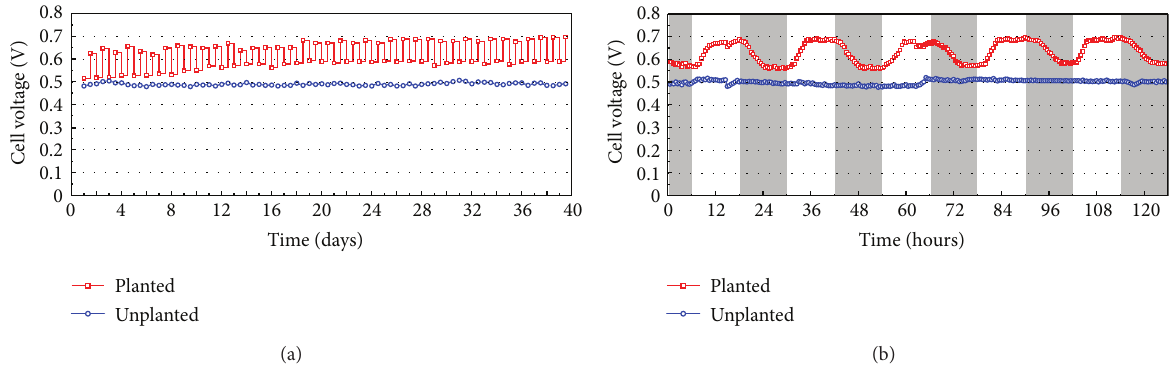
Figure 2: Continuous records of voltage with a fixed external load of 1000 Ω for the planted CW-MFC and unplanted CW-MFC. (a) A daily record of voltages at 0:00 (night through time) and 12:00 (day peak time) from May 3 to June 10; (b) half-hourly records of voltages from June 12 to June 16.